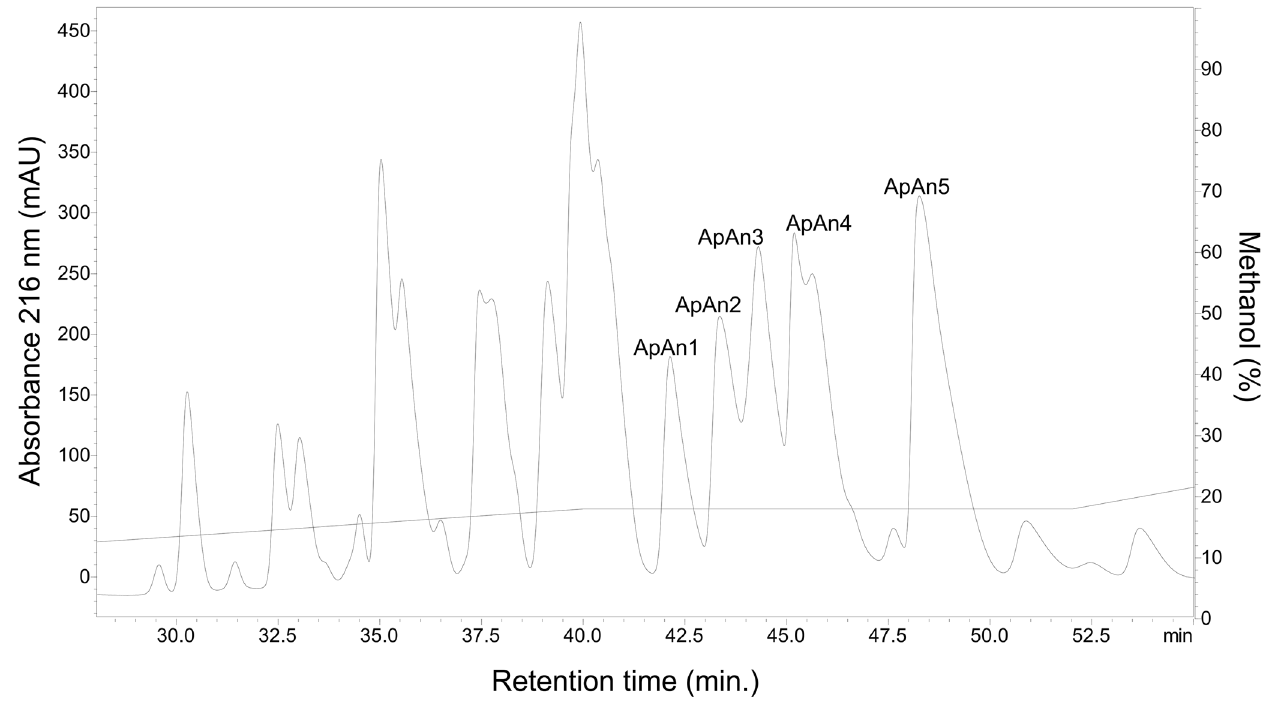
Figure 2. Rechromatography (step 2) of the ApAn fraction by RP-HPLC on a C18 column with optimized methodology (0 to 18% solvent B in 40 min, 18% B from 40 to 50 min and 18 to 30% B of 50 to 60 min). Solvent B: 0.24% TFA v/v in methanol. Fractions of interest were named as ApAn1, ApAn2, ApAn3, ApAn4 and